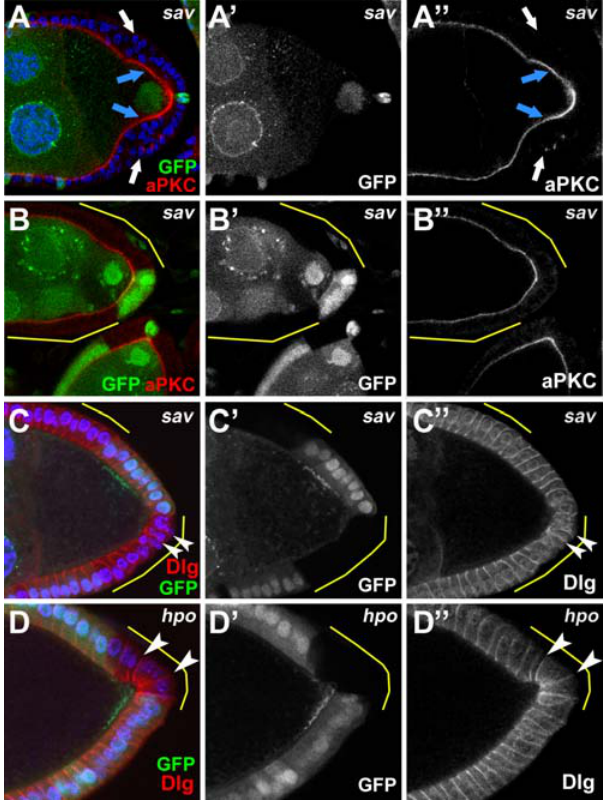
Figure 7. Apical-basal polarity in Hpo-defective follicle cells. sav mutant follicle cells that remain in contact with the germline display correct localization of the apical marker, aPKC (A, blue arrows; compare to B which shows wildtype cell pattern (GFP-positive cells) as well as no obvious defects in neighboring clone cells). sav clone cells in outer layers of a multilayered clone, however, do not show apical accumulations (A, white arrows). Localization of the basal-lateral marker Dlg appears largely correct in both sav (C) and hpo (D) clones (white arrowheads), but see Results for further description.